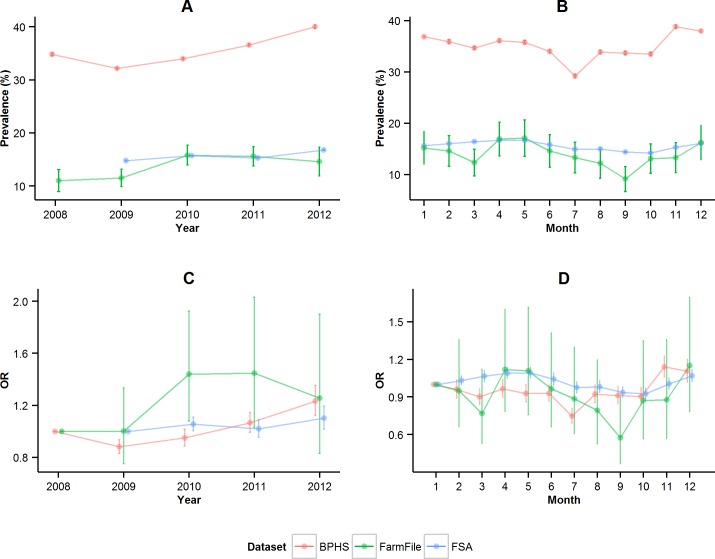
Respiratory disease conditions in the three datasets (FSA, BPHS and FarmFile).Prevalence estimate (dots) and 95% confidence interval (bars) from 2008 to 2012 (A) and from January (1) to December (12) (B). Logistic regression odds ratio (OR) (dots) and 95% confidence interval (bars) from 2008 to 2012 (C) and from January (1) to December (12) (D).